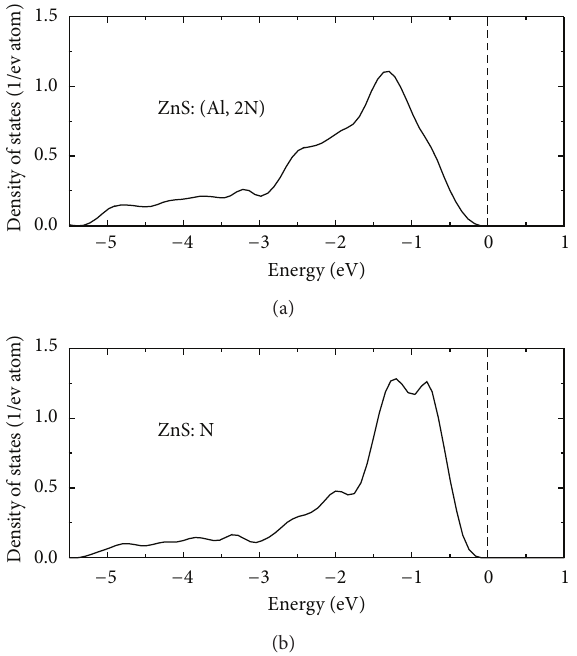
Figure 3: DOS of N-p states for (a) ZnS codoped with Al and 2N species and (b) ZnS doped with the N atom.